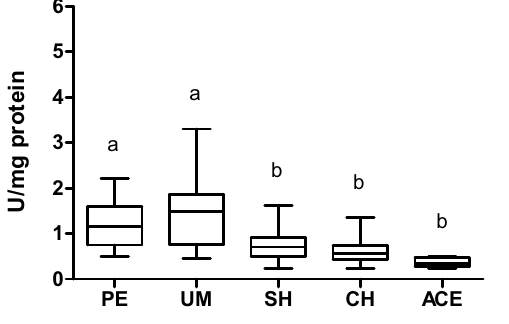
Fig. 3 – CuZnSOD activity in the endometrium of patients diagnosed with: polypus endometrii (PE), uterus myomatosus (UM), simple hy- perplasia (SH), complex hyperplasia (CH) and adenocarcinoma en- dometrii (ACE). Mean SOD activities ( ± SD) are represented by the box; medians are plotted inside the box; the whiskers extend to the 5 th and 95 th percentiles. Values not designated by the same letter (a, b) are significantly different (p < 0 . 05).